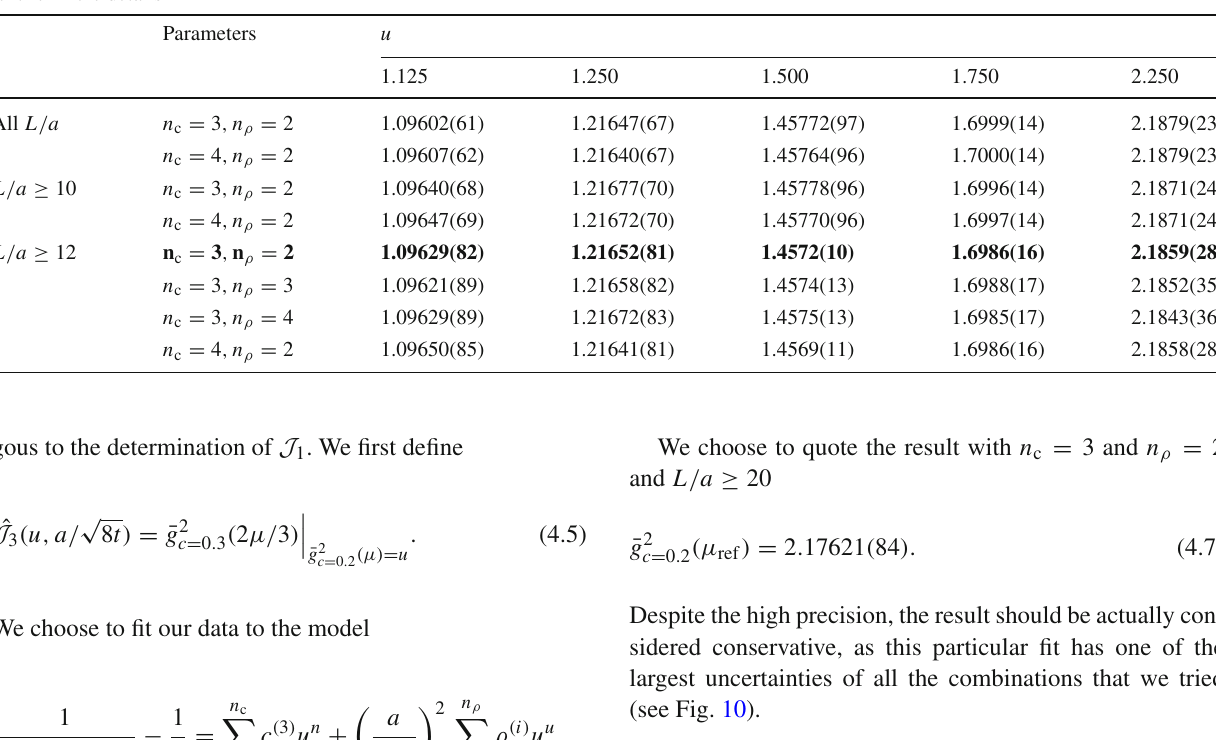
Table 2 Values of the continuum function J 2 ( u ) for different fit parametrizations and cuts (see Eq. (4.2)). In bold we show our preferred fit. See text for more